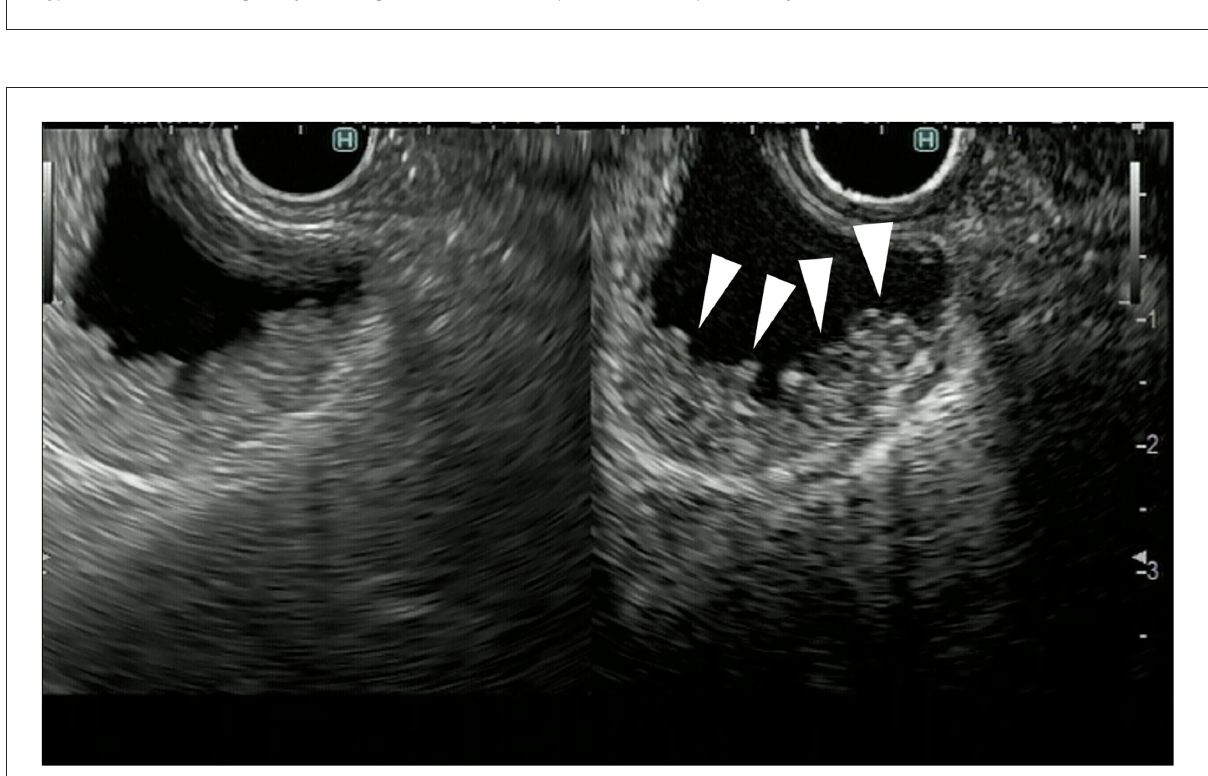
FIGURE6 Fundamental B-mode EUS for gallbladder wall thickening. Gallbladder adenocarcinoma: gallbladder wall thickening of more than 10mm, hypoechoic internal echogenicity, inhomogeneous internal echo pattern, and disrupted wall layer.